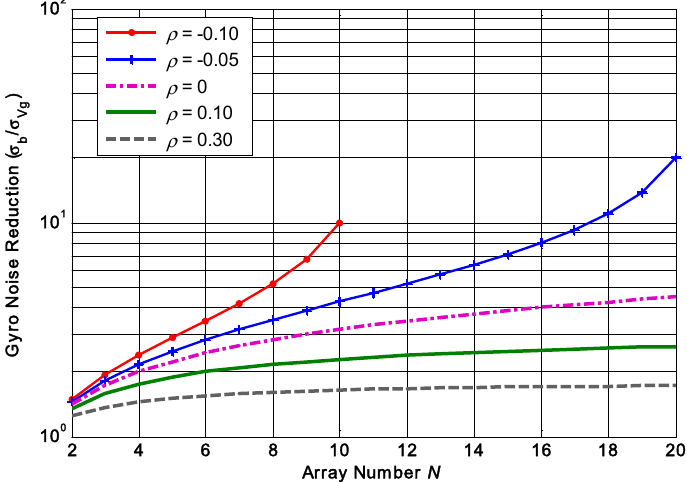
Figure 4. Plot of the relationship between gyroscope drift reduction and array number N with various correlation factor ( ρ = − 0.05, − 0.1, 0, 0.1, 0.3).